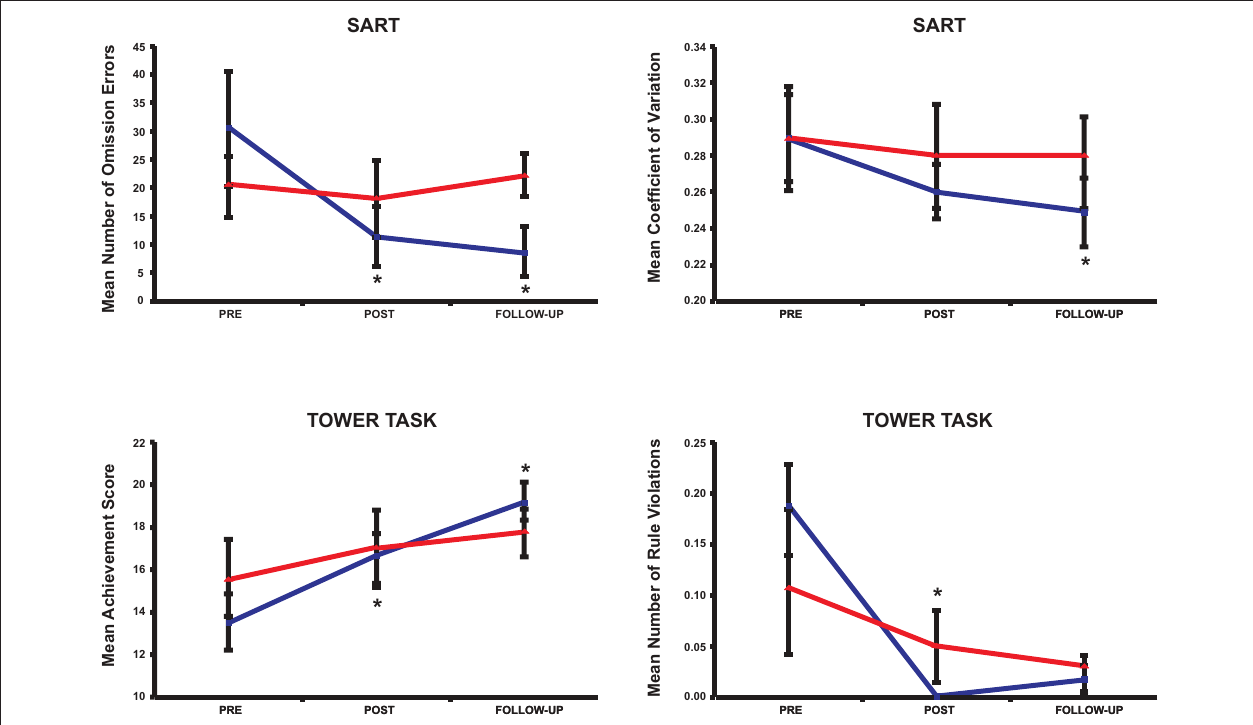
FiGuRE 1 | Effects of GMT vs. BHW on SART errors of omission (top left), SART coefficient of variation (top right), Tower Test Achievement Score (bottom left) and Tower Test rule violations per item (bottom right). *Significantly different from baseline for GMT. The symbols represent the mean values and the error bars represent the